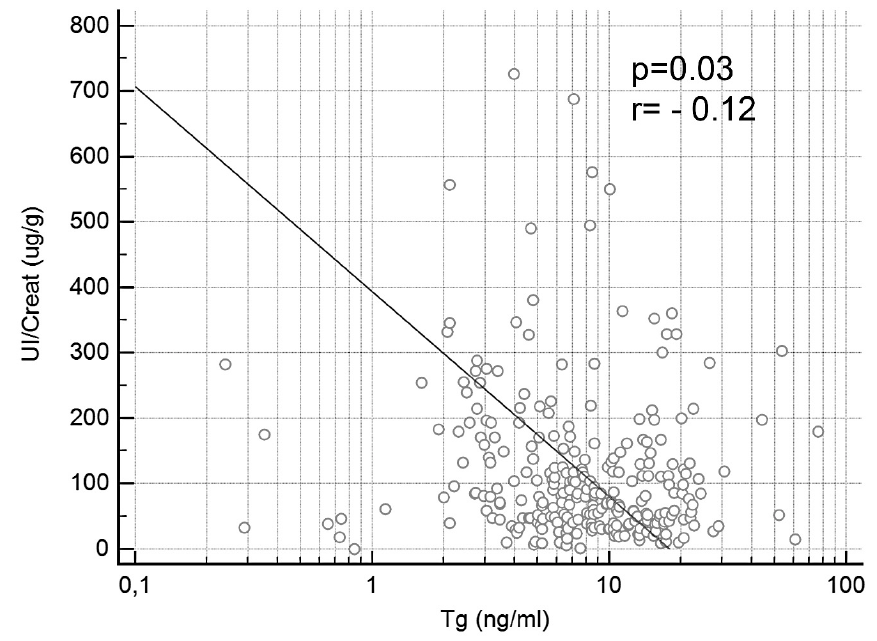
/ creatinine ratio and